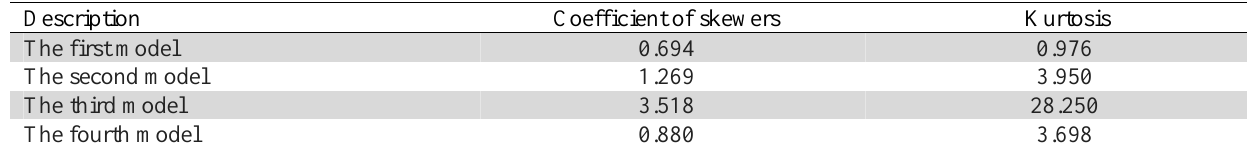
Evaluation for normality distribution of